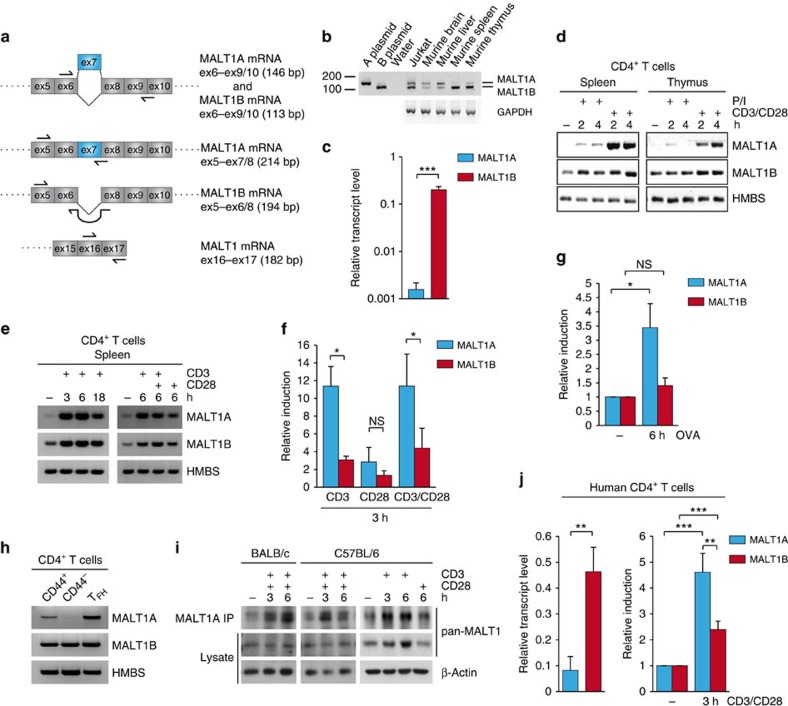
TCR ligation induces MALT1 splicing and exon7 inclusion in CD4+ T cells.(a) Scheme of MALT1 primers amplifying MALT1A (ex5–ex7/8), MALT1B (ex5–ex6/8) or MALT1A/B (ex6–ex9/10 or ex16–ex17). (b) Analysis of MALT1 mRNA levels by RT–PCR in Jurkat T cells and different murine tissues from BALB/c mice using ex6–ex9/10 primers amplifying both isoforms. GAPDH served as control. (c–f) MALT1A and MALT1B mRNA levels in CD4+ T cells from BALB/c mice were investigated by qPCR (c,f) or semi-qPCR (d,e) using isoform-specific ex5–ex7/8 or ex5–ex6/8 primers. Transcript levels were normalized to Hydroxymethylbilane Synthase (HMBS) mRNA levels. For semi-qPCR, amplification cycles were adjusted for MALT1A (35 cycles) and MALT1B (28 cycles). (g) MALT1A and MALT1B mRNA levels were analysed in OT-II CD4+ T cells cultured for 6 h alone or with irradiated wild-type APCs unloaded or loaded with 1 μg ml−1 OVA peptide. HMBS served as internal control and relative induction was determined comparative to unloaded APCs cultured with OT-II T cells. (h) Activated CD62L−CD44+ effector memory T cells, naive CD62L+CD44− T cells and CXCR5+PD1+ T-follicular helper (TFH) cells were sorted from immunized BALB/c mice. RNA was isolated, and MALT1A and MALT1B levels were analysed by semi-qPCR using isoform-specific primer pairs. (i) CD4+ T cells from BALB/c and C57BL/6J mice were treated with anti-CD3, anti-CD28 or both stimuli. After lysis, MALT1A was precipitated using anti-MALT1A antibody. A pan-MALT1 antibody was used for detection by western blot (WB). (j) Primary human CD4+ T cells from four donors were stimulated with anti-CD3/CD28 for 3 h. MALT1A and MALT1B mRNA levels were measured by qPCR using human MALT1A- or MALT1B-specific primers. RP2 served as internal control and relative induction was determined comparative to unstimulated cells. Data are representative for two (b,d) or three (c,e–i) or four (j) independent experiments. Depicted is the mean±s.d. (c,e–i; n=3) or (j; n=4). *P<0.05; **P<0.01; ***P<0.001; NS, not significant; unpaired t-test.